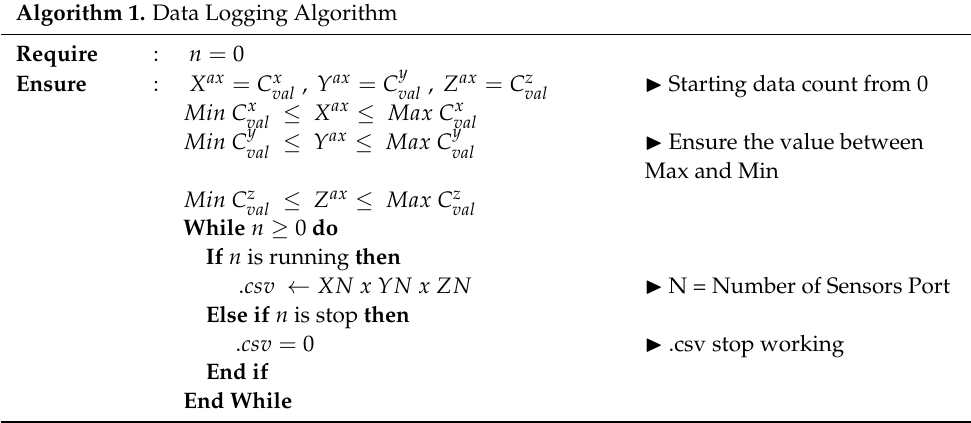
Algorithm 1. Data Logging Algorithm